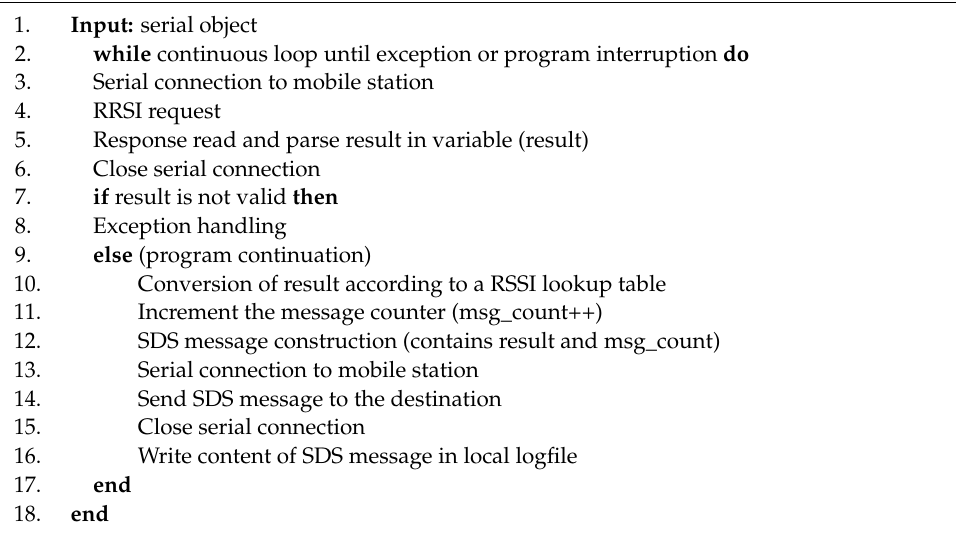
Algorithm 1. Serial connection, RSSI request, message construction and logfile